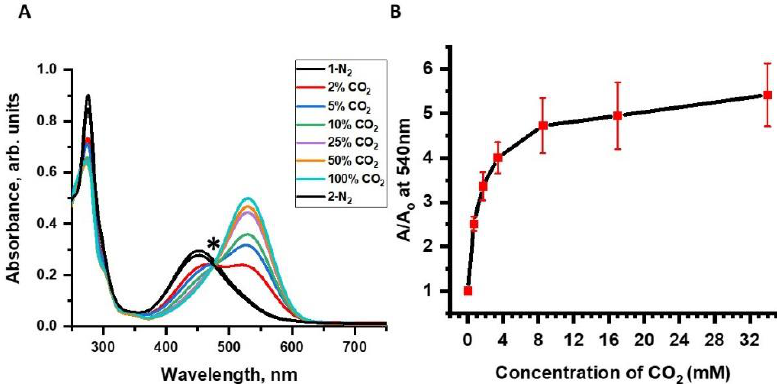
Figure 5. Changes in absorption of NR buffer solution (pH 7.3) purged with different concentrations of CO 2 gas (0.0 mM, 0.68 mM, 1.7 mM, 3.4 mM, 8.5 mM, 17.0 mM, 34.0 mM — 0%, 2%, 5%, 10%, 25%, 50%, and 100%, respectively). ( A ) Changes in full absorption spectra. The ‘*’represents the isosbestic point at around 470 nm. ( B ) Changes in absorption signal vs. pH at 540 nm wavelength for one cycle at different gas concentrations.